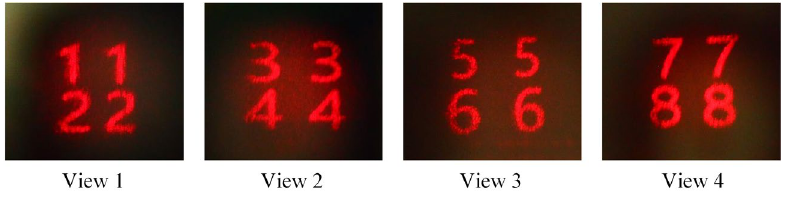
Figure 7. The four-view reconstructions.